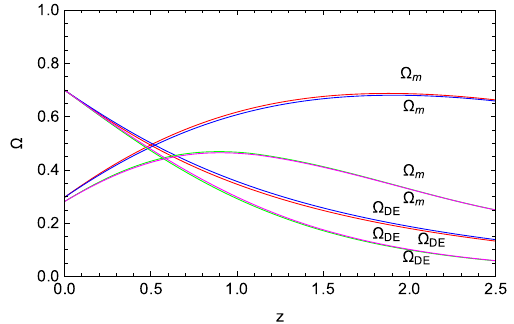
Fig. 7 Evolution of density parameter of matter and Barrow holo- graphic dark energy, as a function of redshift z , for C = 3 , in unit of M 2 p = 1. The lines corresponds: red: Δ = 0 and k = 0 . 01 ; blue: Δ = 0 . 2 and k = 0 . 01